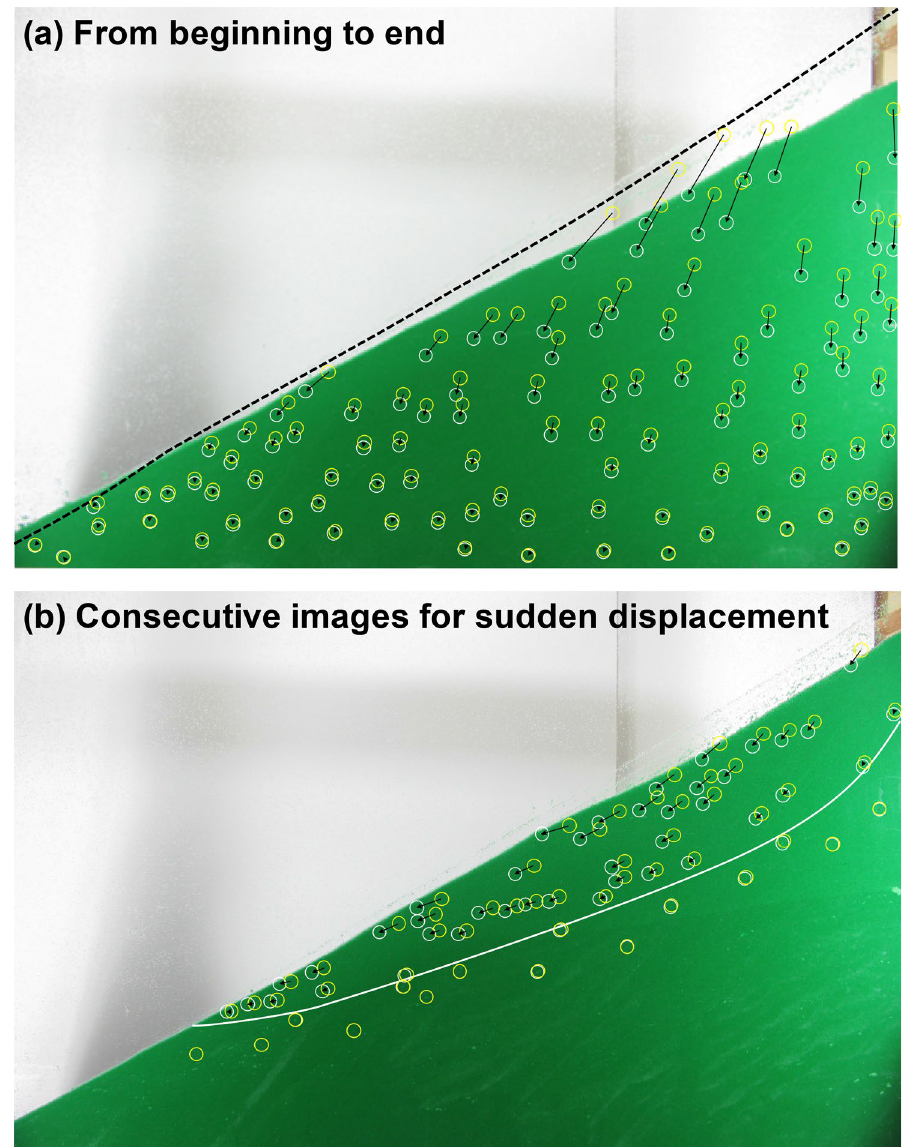
Figure 2. Experimental results. Displacement vectors at visually recognizable points: ( a ) From the beginning to the end of dissolution. Note: The dotted line indicates the original slope surface; ( b ) Sudden shear failure observed during a 5-min photo-interval. This test corresponds to a specimen mixed with a mass fraction SF = 10% of dissolvable particles. Note: Displacement vectors are shown at the same scale in both ( a ) and ( b